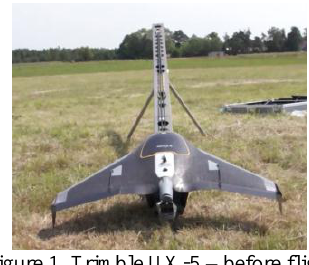
Figure 1. Trimble UX-5 – before flight